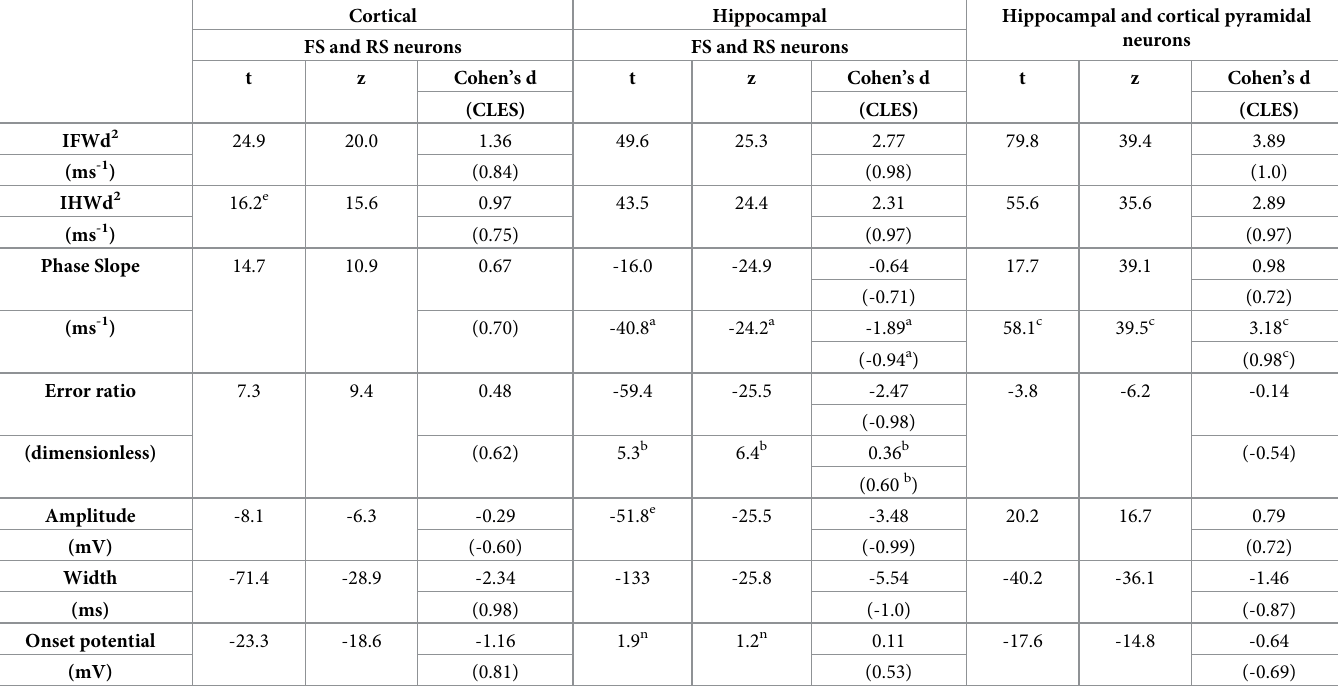
Table 3. Comparison between electrophysiological properties of four neuron types using conventional